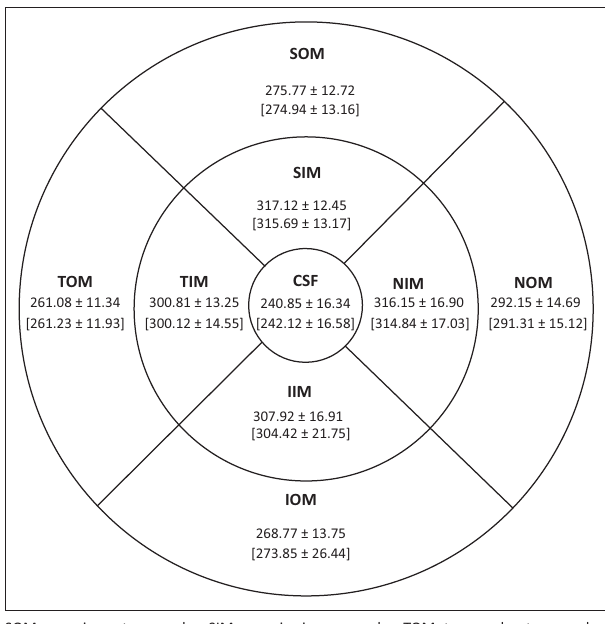
SOM, superior outer macular; SIM, superior inner macular; TOM, temporal outer macular; TIM, temporal inner macular; CSF, central subfield/fovea; NIM, nasal inner macular; NOM, nasal outer macular; IIM, inferior inner macular; IOM, inner outer macular; ETDRS, Early Treatment Diabetic Retinopathy Study. FIGURE 2: An Early Treatment Diabetic Retinopathy Study grid showing mean macular thicknesses and standard deviations (in µ m) for test and retest (square brackets) measurements for the right eyes of participants ( n = 26). TABLE 1: Probability values for Kolmogorov–Smirnov, Lilliefors and Shapiro–Wilk tests for test and retest retinal thickness measurements for the five main ETDRS regions.